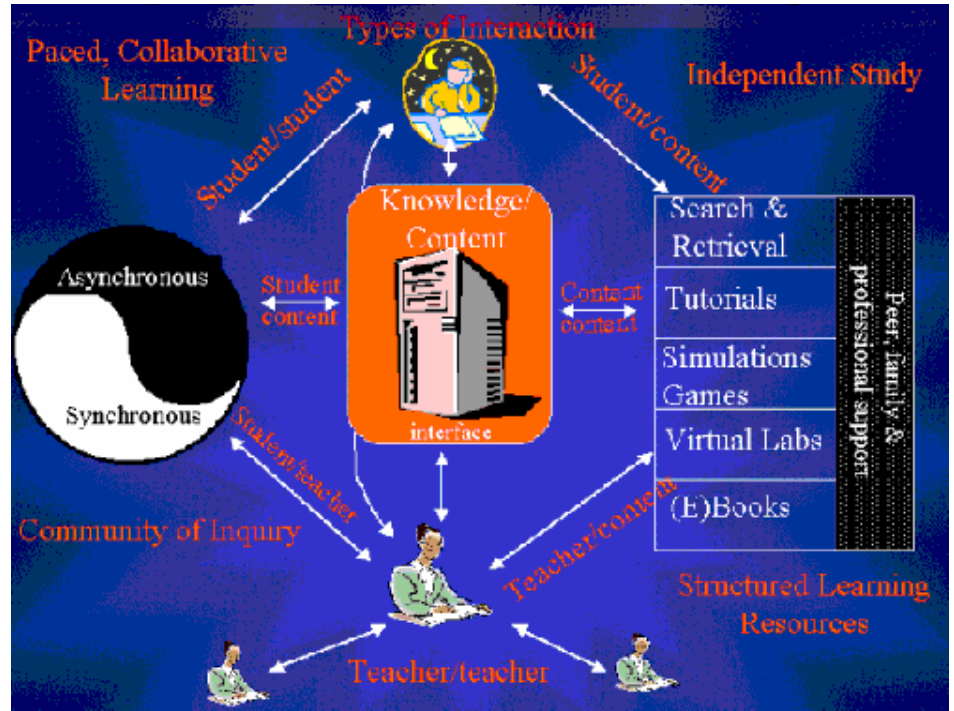
Figure 2 . A Model of Online